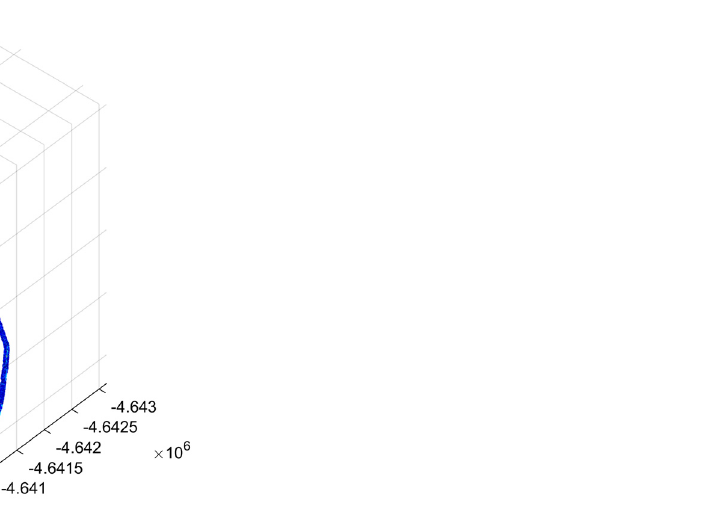
Figure 11. Global georeferenced road map from UNSW to La Perouse (frame: ECEF, unit: meter) from the 3D point cloud-based map.